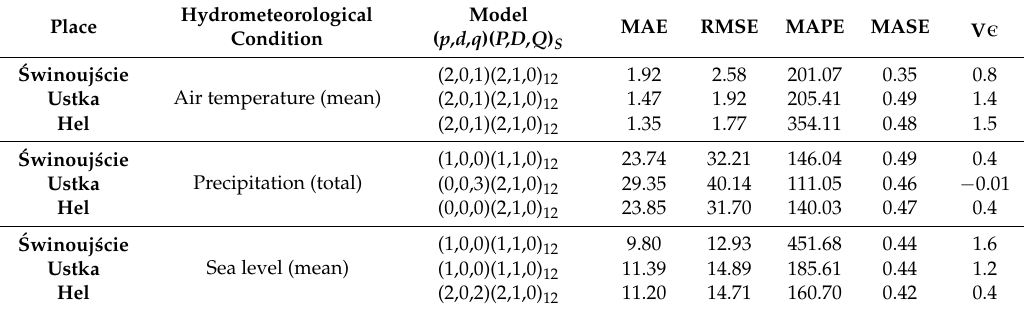
Figure 5. The course of autocorrelation (ACF) and partial autocorrelation (PACF) functions for residuals of decomposition models (white noise effect), using atmospheric precipitation in Ustka as an example. Table 3. ARIMA models for hydrometeorological conditions in the Polish Baltic coastal zone and prediction-error criteria (RMSE, MAE, MAPE, MASE,